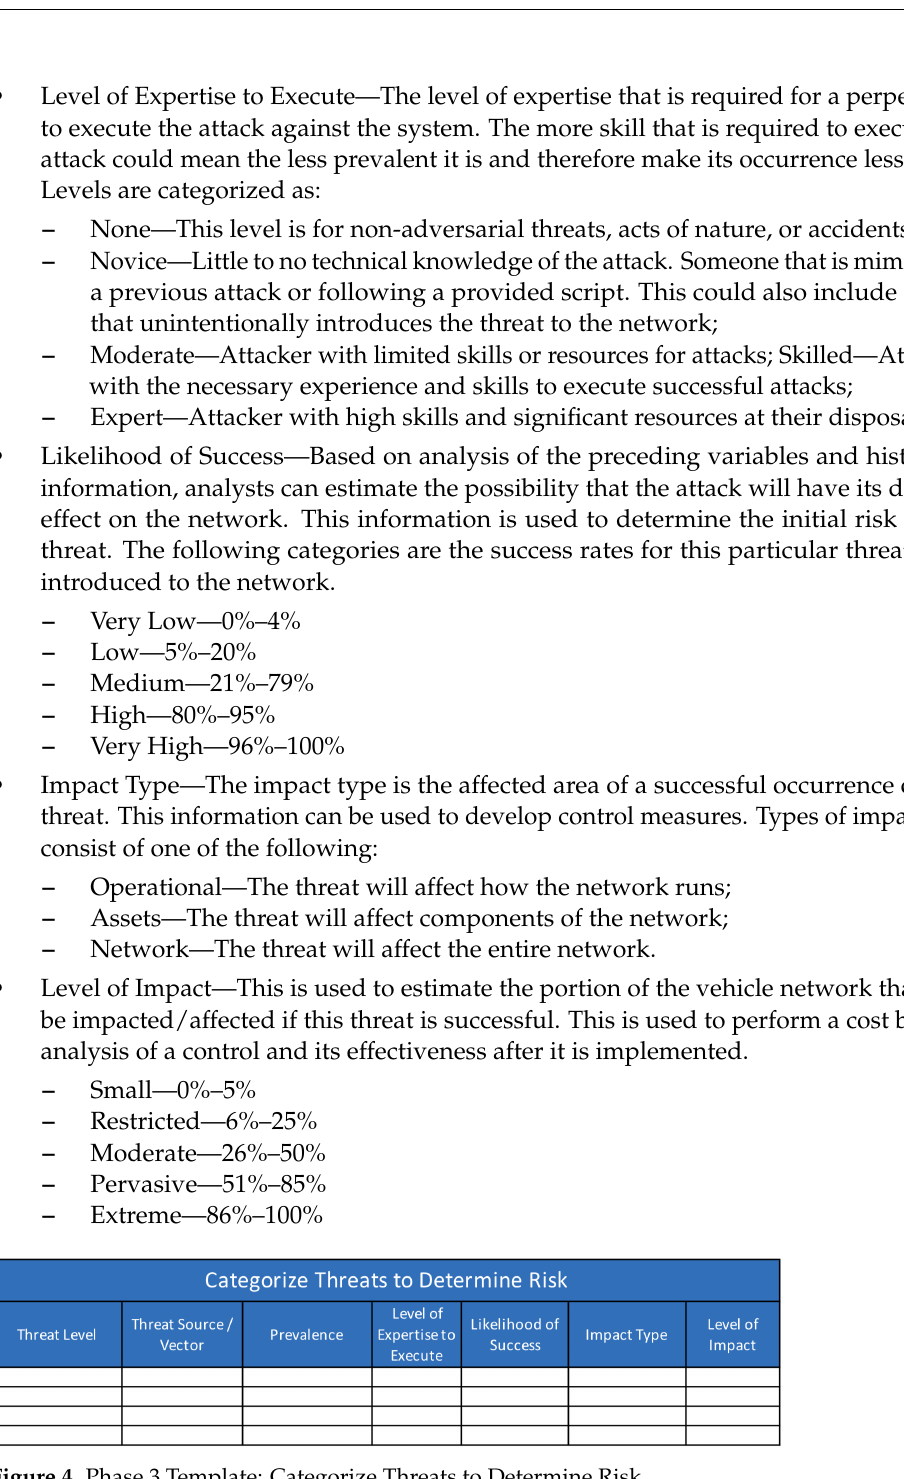
Figure 4. Phase 3 Template: Categorize Threats to Determine